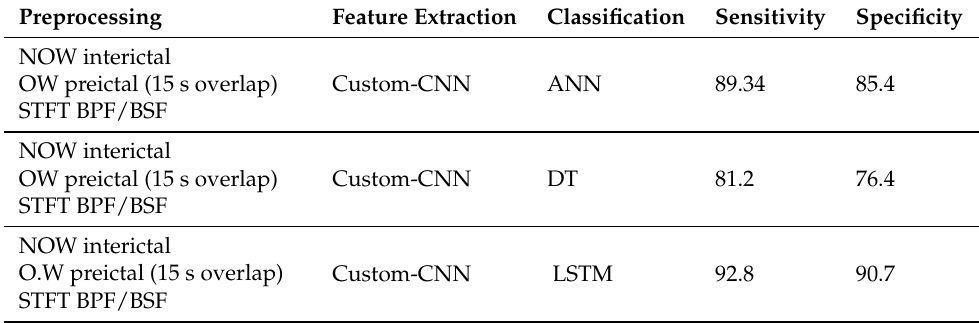
Table 5. Results of various classifiers used in the proposed system.